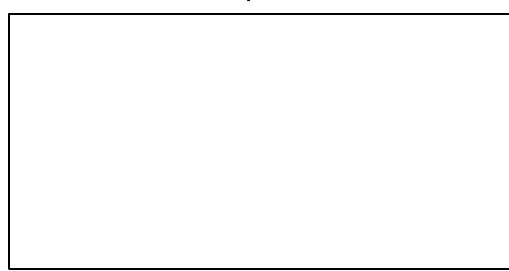
Table II : Total poisoning cases in different